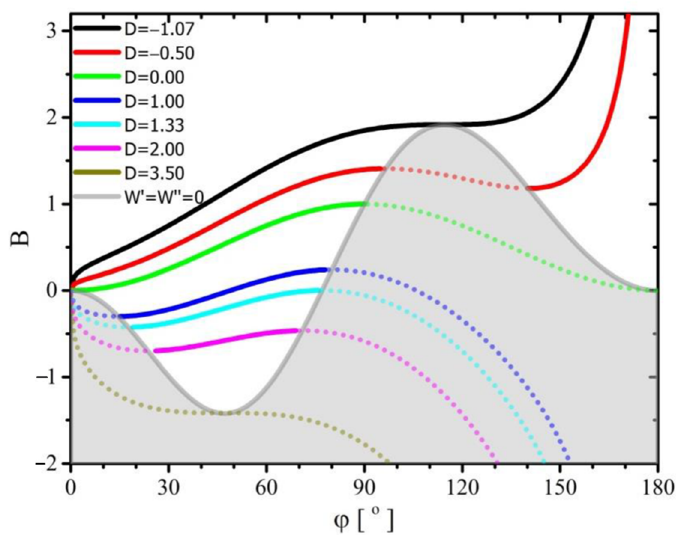
Figure 3. The dependence of the parameter (cid:1828) = (cid:3097) (cid:3255)(cid:3258) on the contact angle and several values of the (cid:3097) (cid:3252)(cid:3258) parameter D = F L . The gray area marks solutions to the unstable balance of σ CI R π parameter (cid:1830) = (cid:3007) (cid:3261) . The gray area marks solutions to the unstable balance of forces. (cid:3097) (cid:3252)(cid:3258) (cid:3019) (cid:3343)